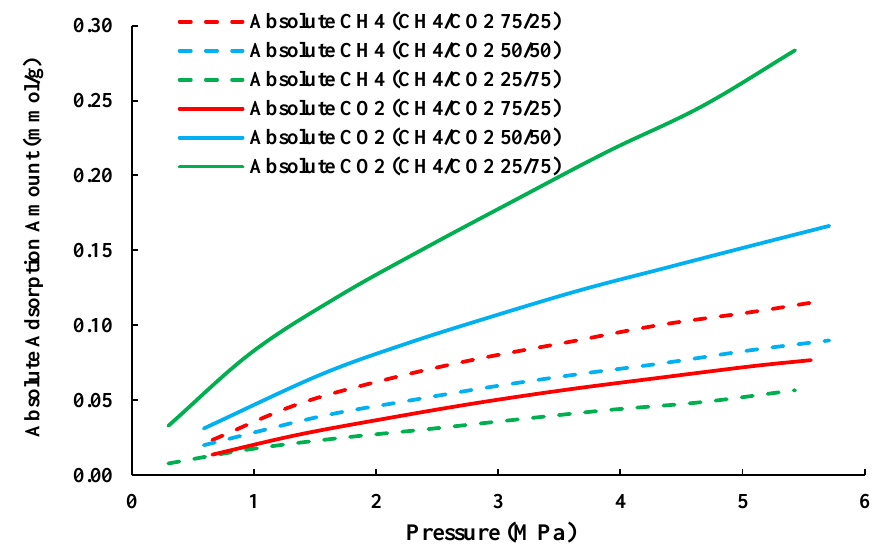
Figure 4. Absolute adsorption isotherms of each component in CH 4 /CO 2 mixtures in shale at 313.15 K.